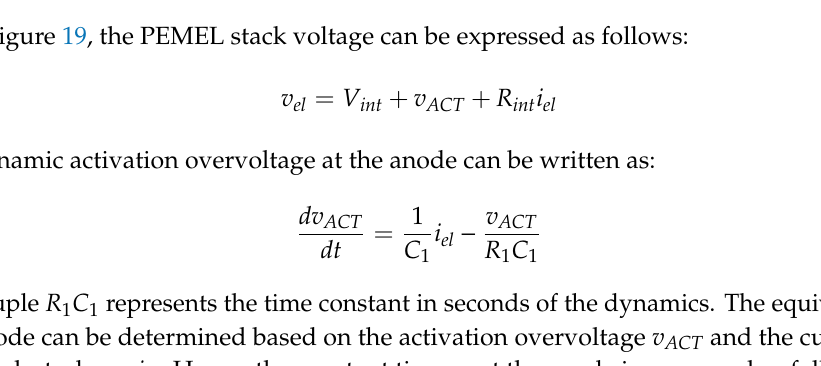
Figure 19. Equivalent electric model of the dynamic operation of a PEMEL.